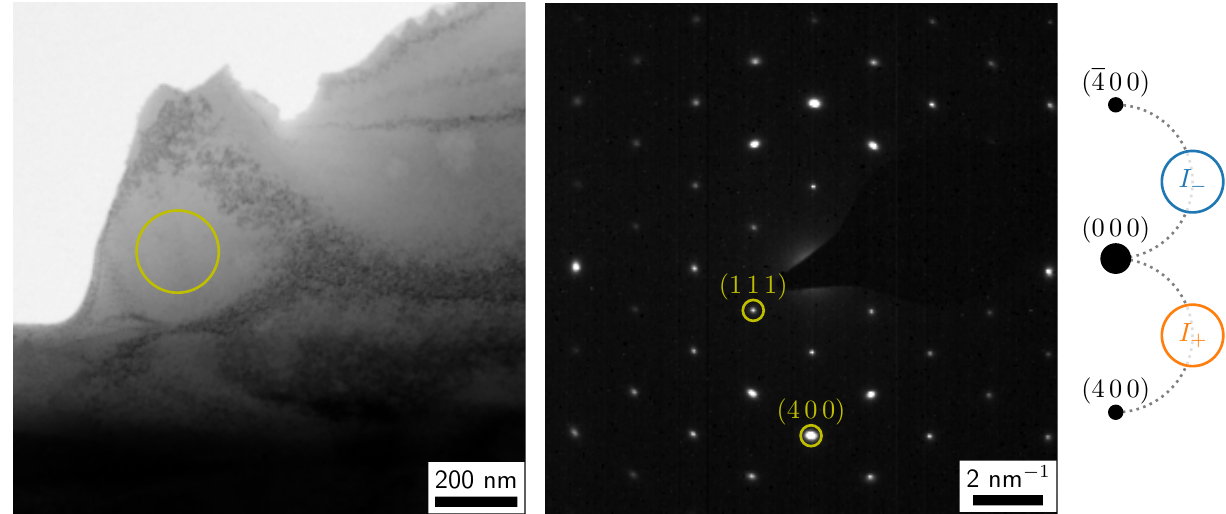
Figure 5. TEM bright-field overview image ( left ), corresponding diffraction pattern in ( 011 ) zone axis ( middle ) and schematic of the EMCD measurement positions in systematic row condition ( right ). The sample position used for the EMCD experiments is marked by a yellow circle in the bright-field image, the positions for I + and I − are marked by the orange and blue circles. Both the image and the diffraction pattern were recorded at 200kV. Note that the weak, kinematically forbidden ( 200 ) reflections can be attributed to double diffraction [36] in the thicker part of the sample visible at the bottom of the bright-field image; they are negligible in the thin part of the sample used for the EMCD